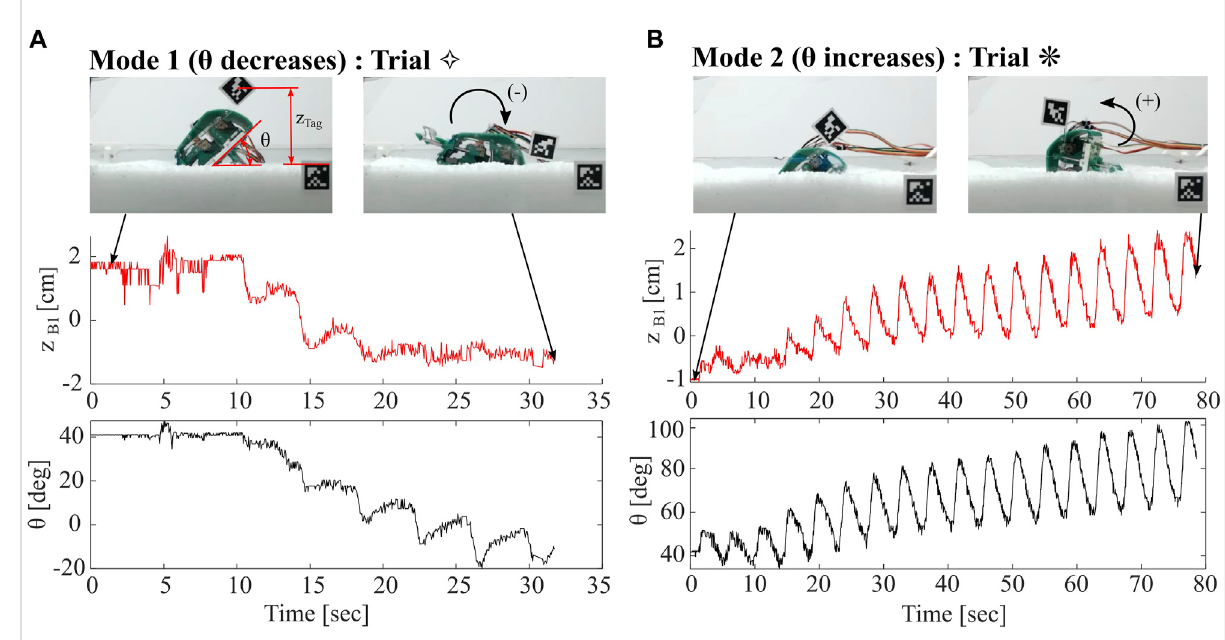
FIGURE 10 Comparison of Robot Burrowing Modes. (A) Mode 1, in which robot body pitch decreases from its initial condition and depth z B 1 decreases (B) Mode 2, in which robot body pitch oscillates signi fi cantly, with an increase from its initial condition. Depth z B 1 oscillates with net increase over the